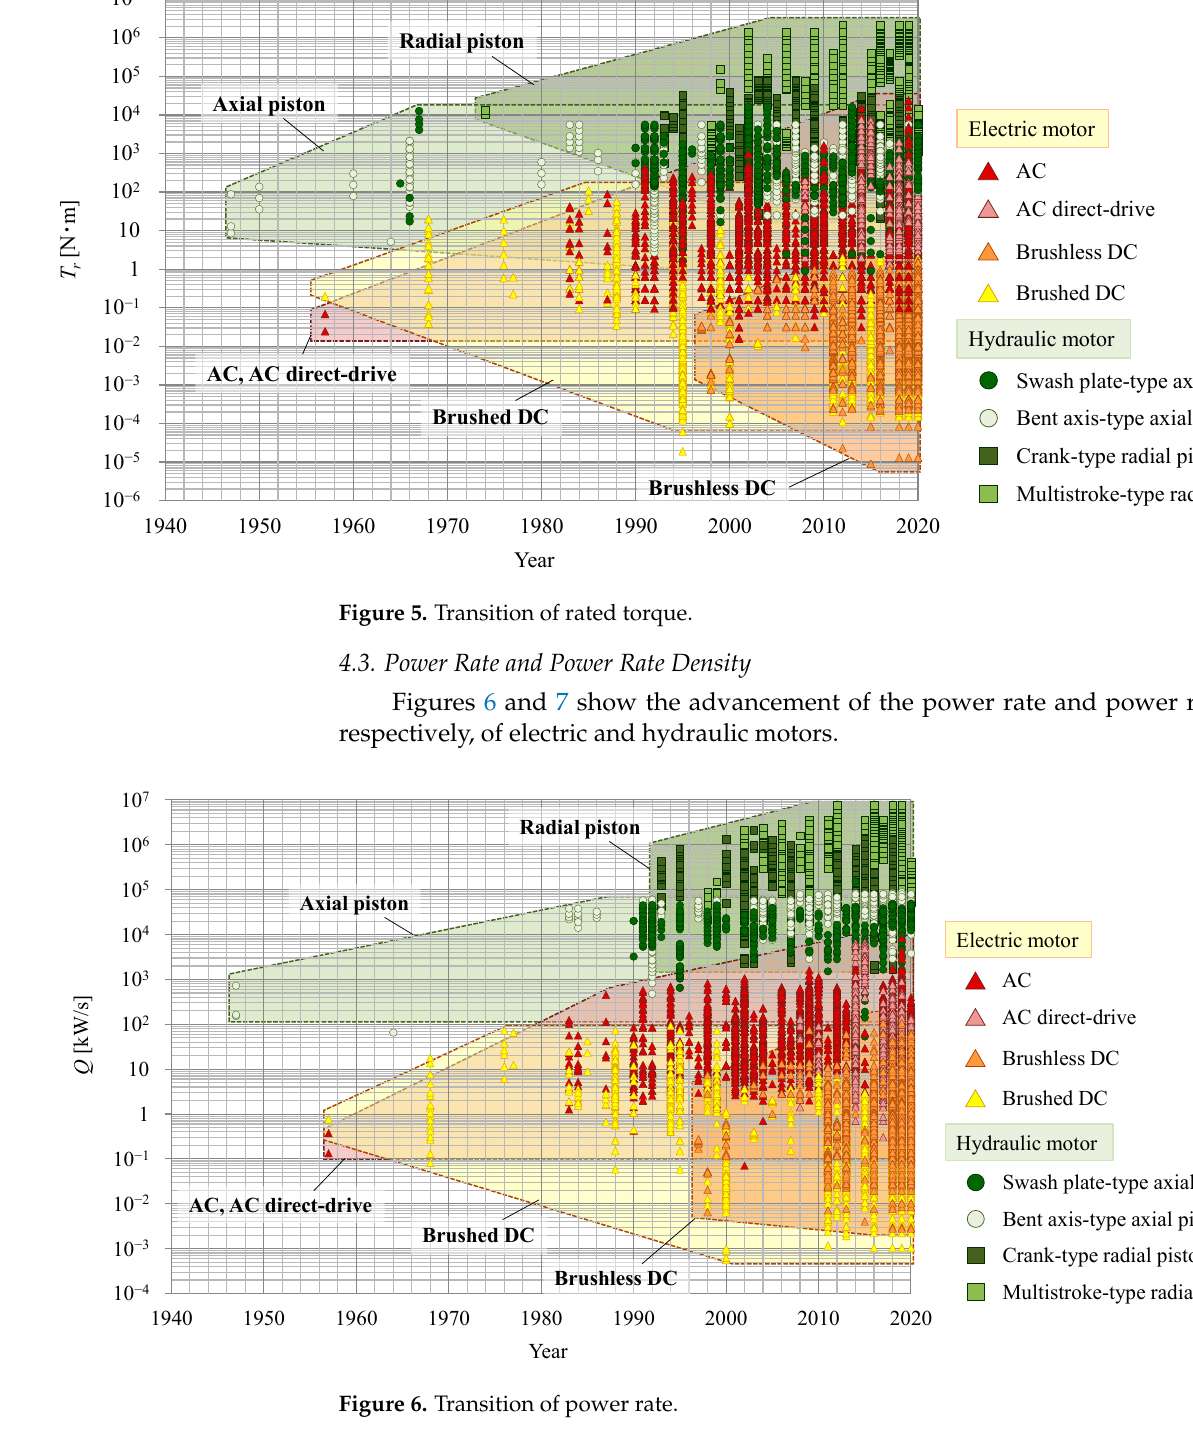
Figure 4. Transition of motor weight.